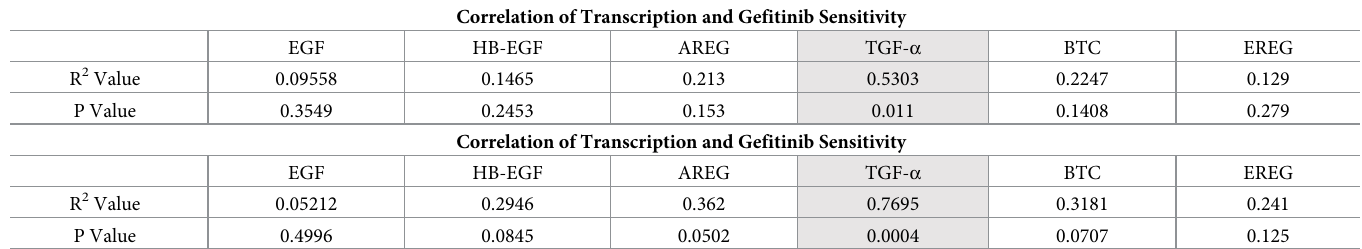
Table 3. Correlations between EGFR ligand transcription to EGFR inhibitors